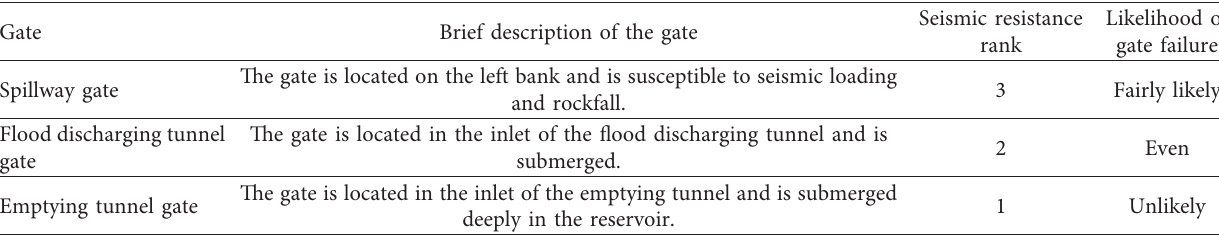
Table 3: Ranks of seismic resistance of gate and linguistic descriptions of the likelihood of gate failure.